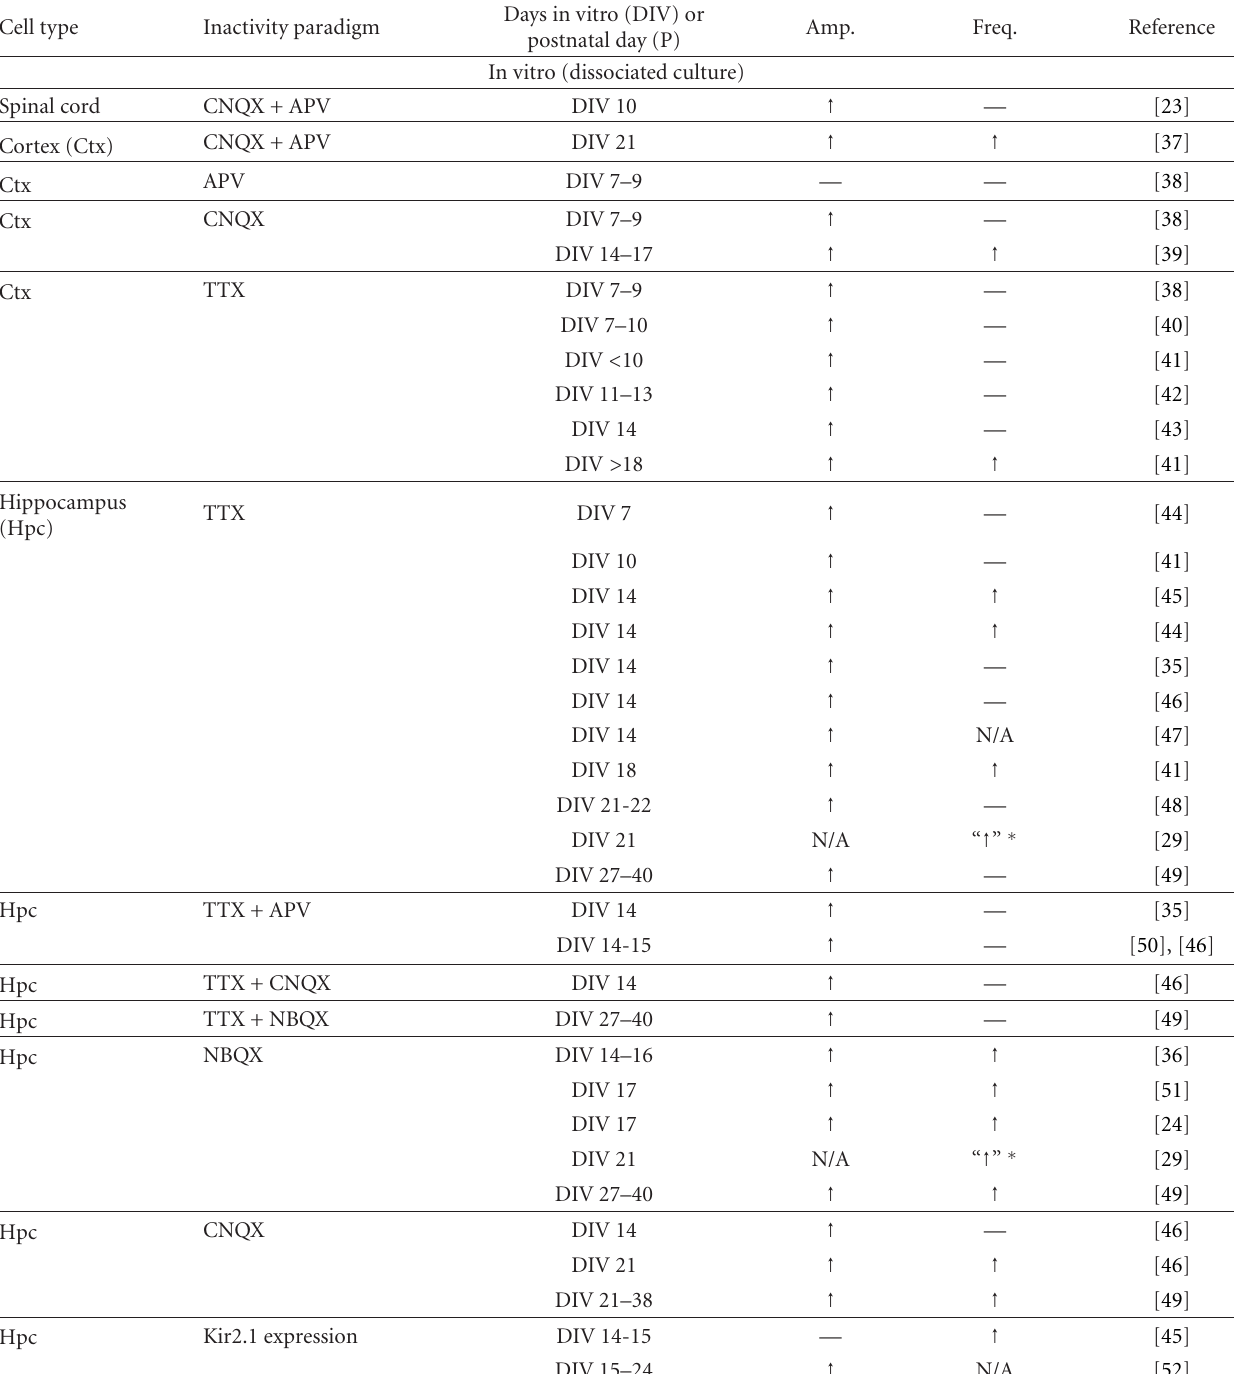
Table 1: Homeostatic synaptic adaptations to chronic inactivity. An overview of select references which have investigated the neuronal response to chronic inactivity via functional analyses of AMPA receptor-mediated excitatory synaptic transmission. References are arranged by cell type (column 1) and inactivity paradigm (column 2). Within each paradigm, studies are listed in ascending age order (column 3). ↑ , ↓ = significant change in mEPSC amplitude or frequency. — = no change in parameter. N/A = parameter was not reported. ∗ mEPSC frequency was not directly